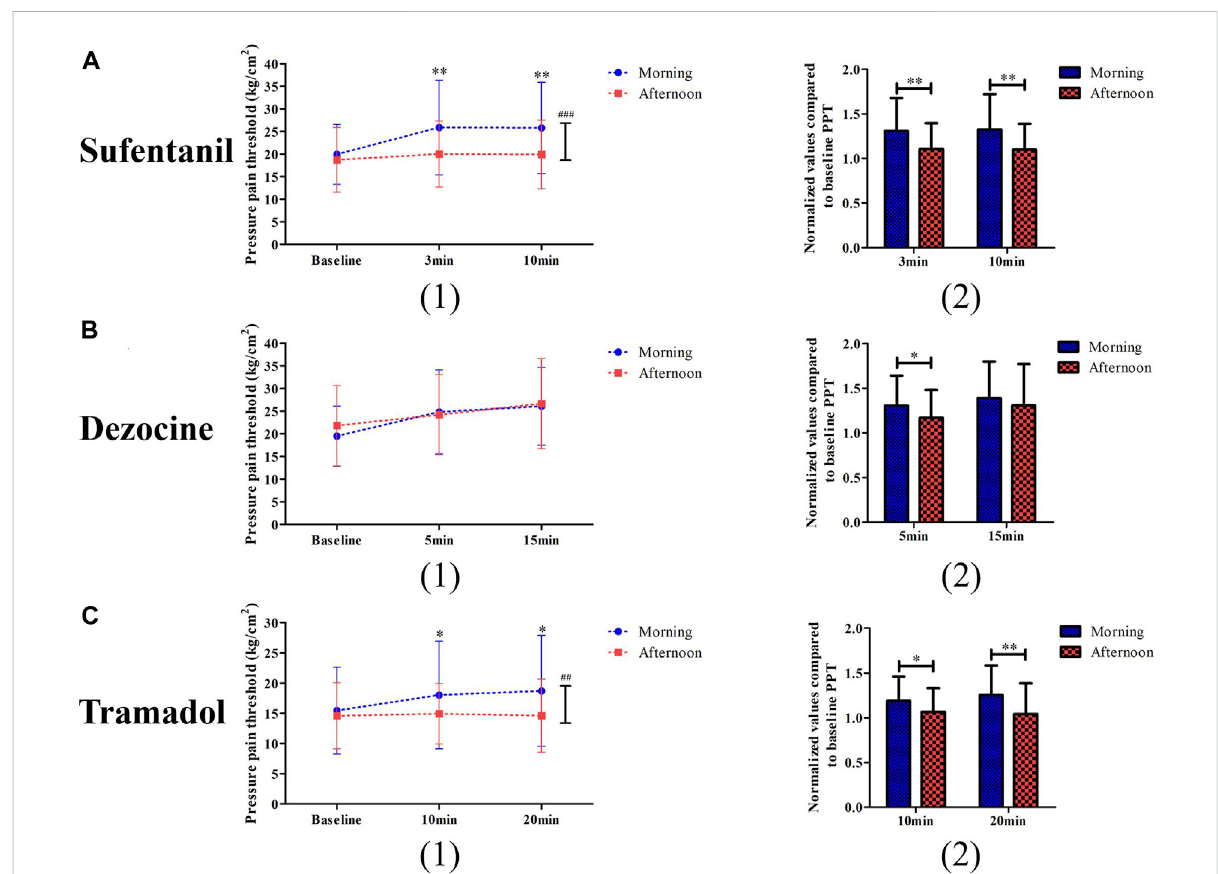
FIGURE 3 Comparisons of pressure pain threshold (1) and its changed levels (2) between the morning group and afternoon group for patients receiving sufentanil treatment (A) , dezocine treatment (B) and tramadol treatment (C) . (* p < 0.05 and ** p < 0.01 compared with the afternoon group; ## p < 0.01 and ### p < 0.001 represents the time and group effects for two way repeat ANOVA